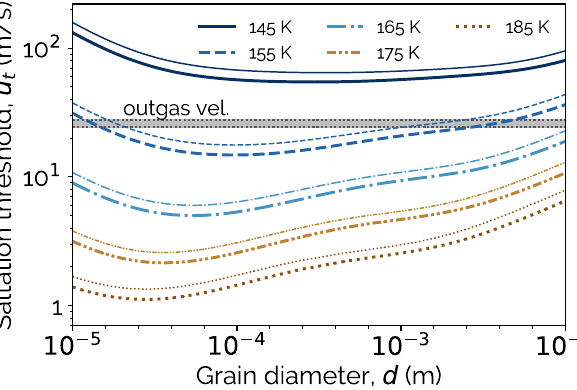
Fig. 4 The saltation threshold compared with outgassing velocities. The lines denote the saltation threshold as a function of temperature. Thick lines are the threshold for SO 2 grains, while the thinner lines are for basalt grains. The range of vapor outgassing velocities for the considered temperatures are shown as the shaded